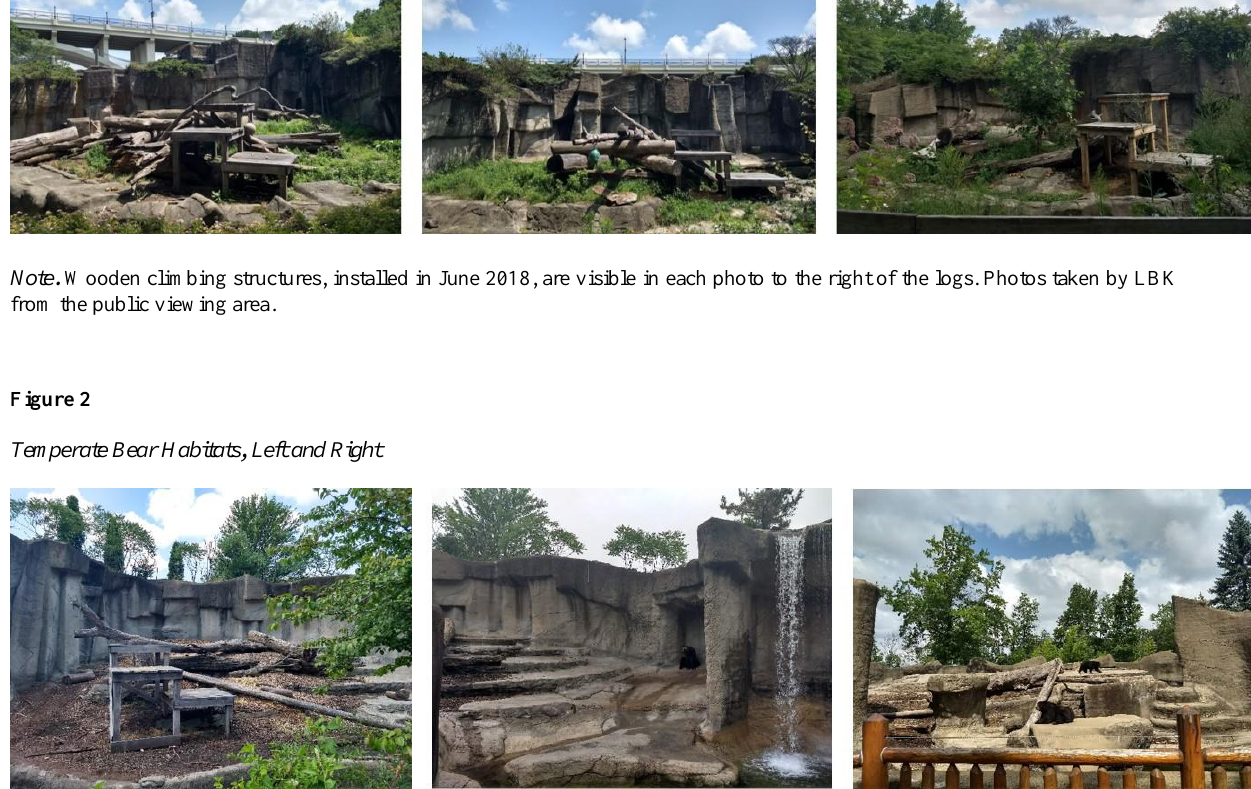
Note. The left and center photos both depict the Left habitat. A wooden climbing structure, installed in June 2018, is visible in the far left photo. Photos taken by LBK from the public viewing